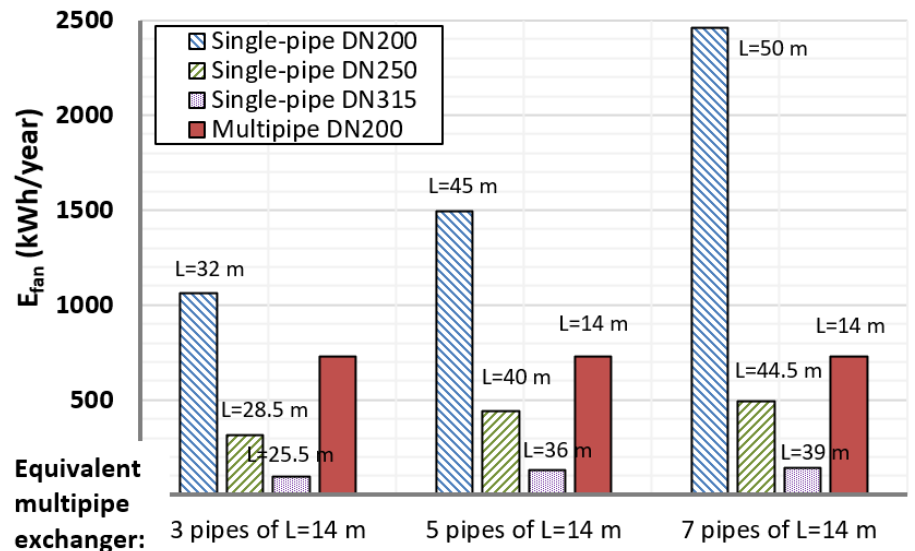
Figure 13. Full-year energy usage for driving the fans for multipipe structures of length L = 14 m and single-pipe structures of equivalent length in the context of heating capacity with different pipe diameters: d = DN200, DN250 or DN315, V = 1500 m 3 /h.